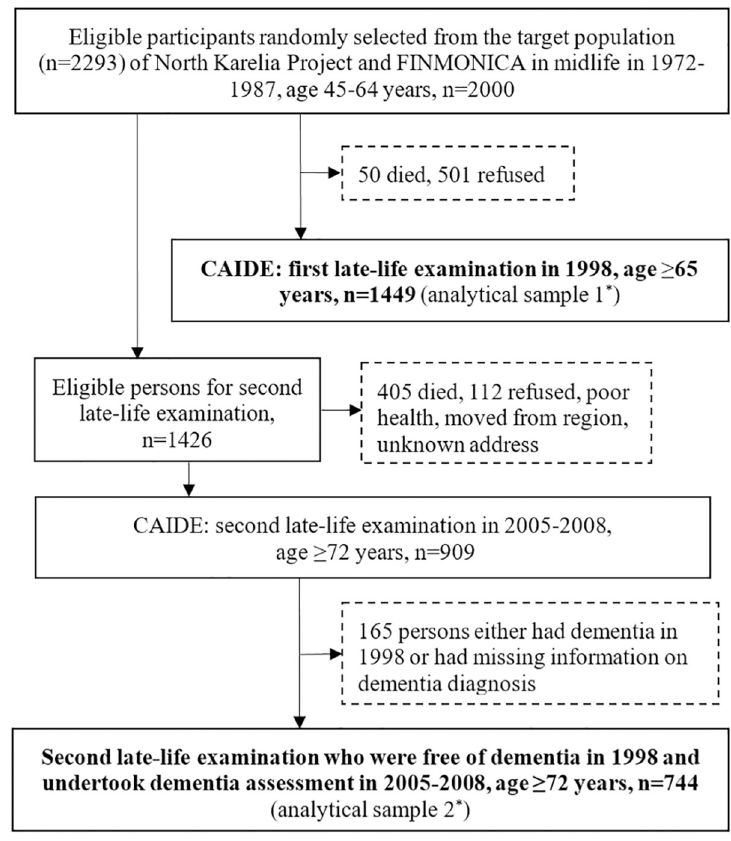
Fig 1. Flowchart of the study population. � The analytical sample 1 was used for analyzing the association between midlife CVH metrics and late-life risk of dementia detected both in the 1998 and 2005 to 2008 examinations. The analytical sample 2 was used for analyzing the association between late-life CVH metrics measured in the 1998 examination as well as the patterns of CVH metrics from midlife to late life (1998) with risk of dementia detected in the 2005 to 2008 examination. CAIDE, Cardiovascular Risk Factors, Aging, and Dementia; CVH, cardiovascular